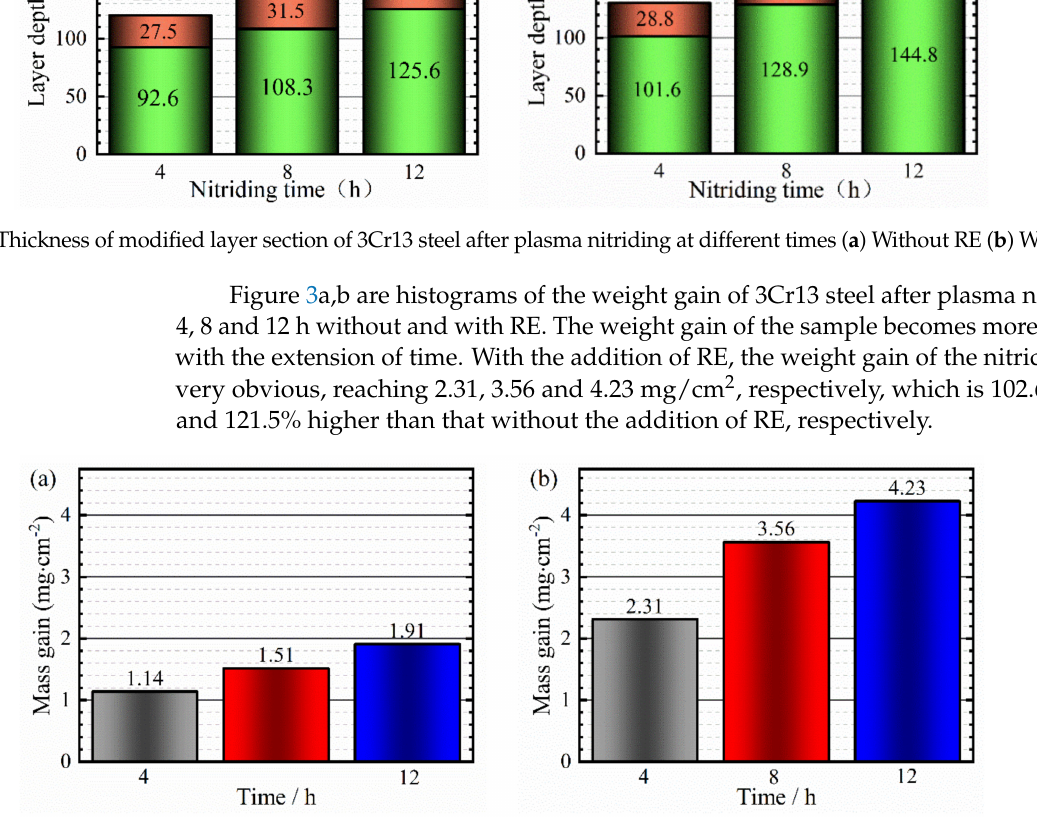
Figure 3. Mass increase per unit area of 3Cr13 steel after plasma nitriding at different times ( a ) Without RE ( b ) With